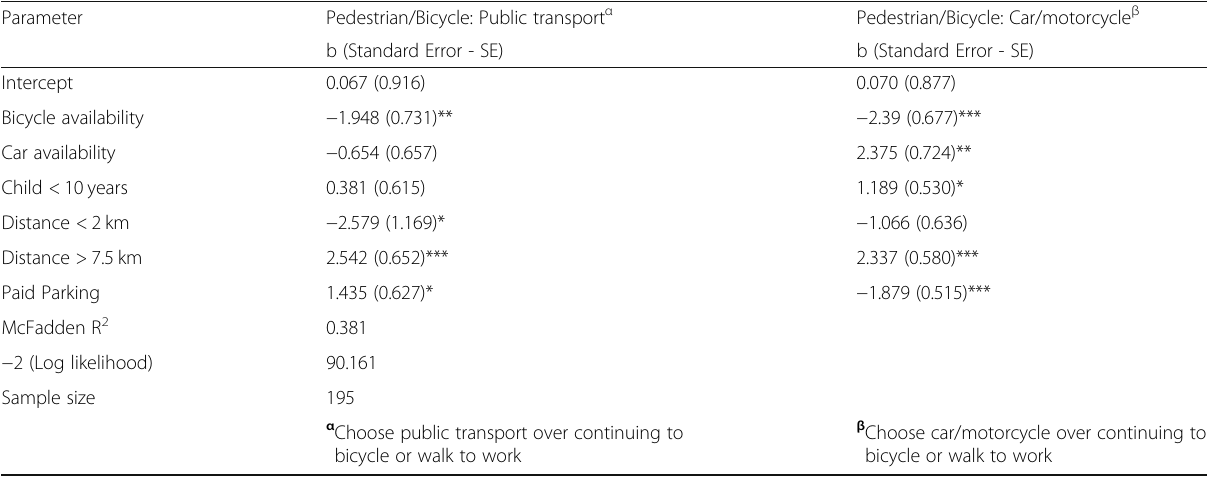
Table 1 Results of the multinomial regression model for active versus motorised transportation modes